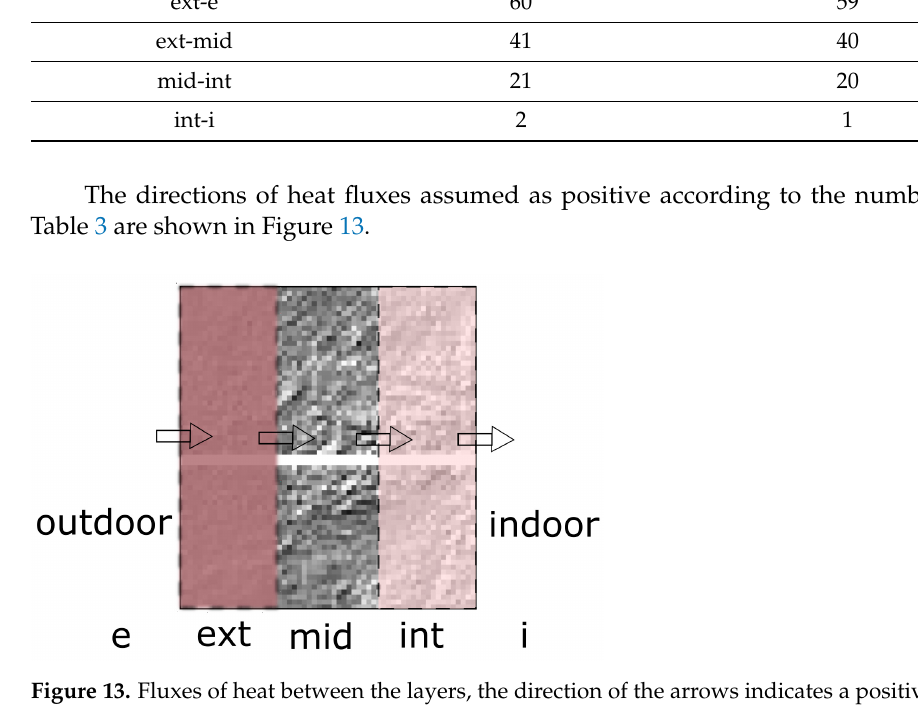
-100-50050100150200 Figure 14. Heat fluxes between the layers on 27 June 2021. According to the drawing, the positive heat flux on the ext-e surface means the heat flows into the wall, and on the int-i surface inversely. The heat flux flows into the wall from both sides due to solar radiation and internal temperature. This stream then flows 0 : 000 : 501 : 402 : 303 : 204 : 105 : 005 : 506 : 407 : 308 : 209 : 1010 : 0010 : 5011 : 4012 : 3013 : 2014 : 1015 : 0015 : 5016 : 4017 : 3018 : 2019 : 1020 : 0020 : 5021 : 4022 : 3023 : 20 H e a t f l u x [ W \ m 2 ]